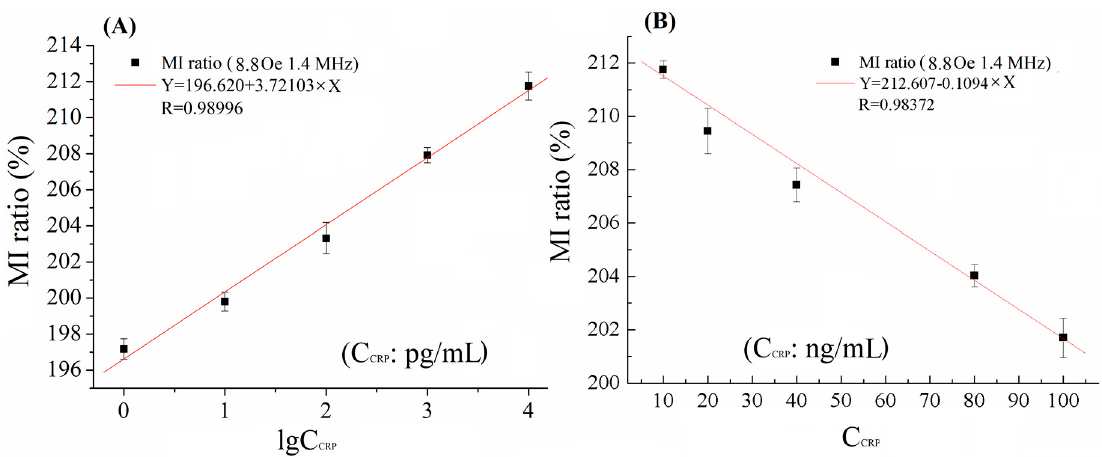
Figure 3. The relationship of MI ratio versus ( A ) low CRP concentrations and ( B ) high CRP concentrations at f = 1.4 MHz and H ex = 8.8 Oe.